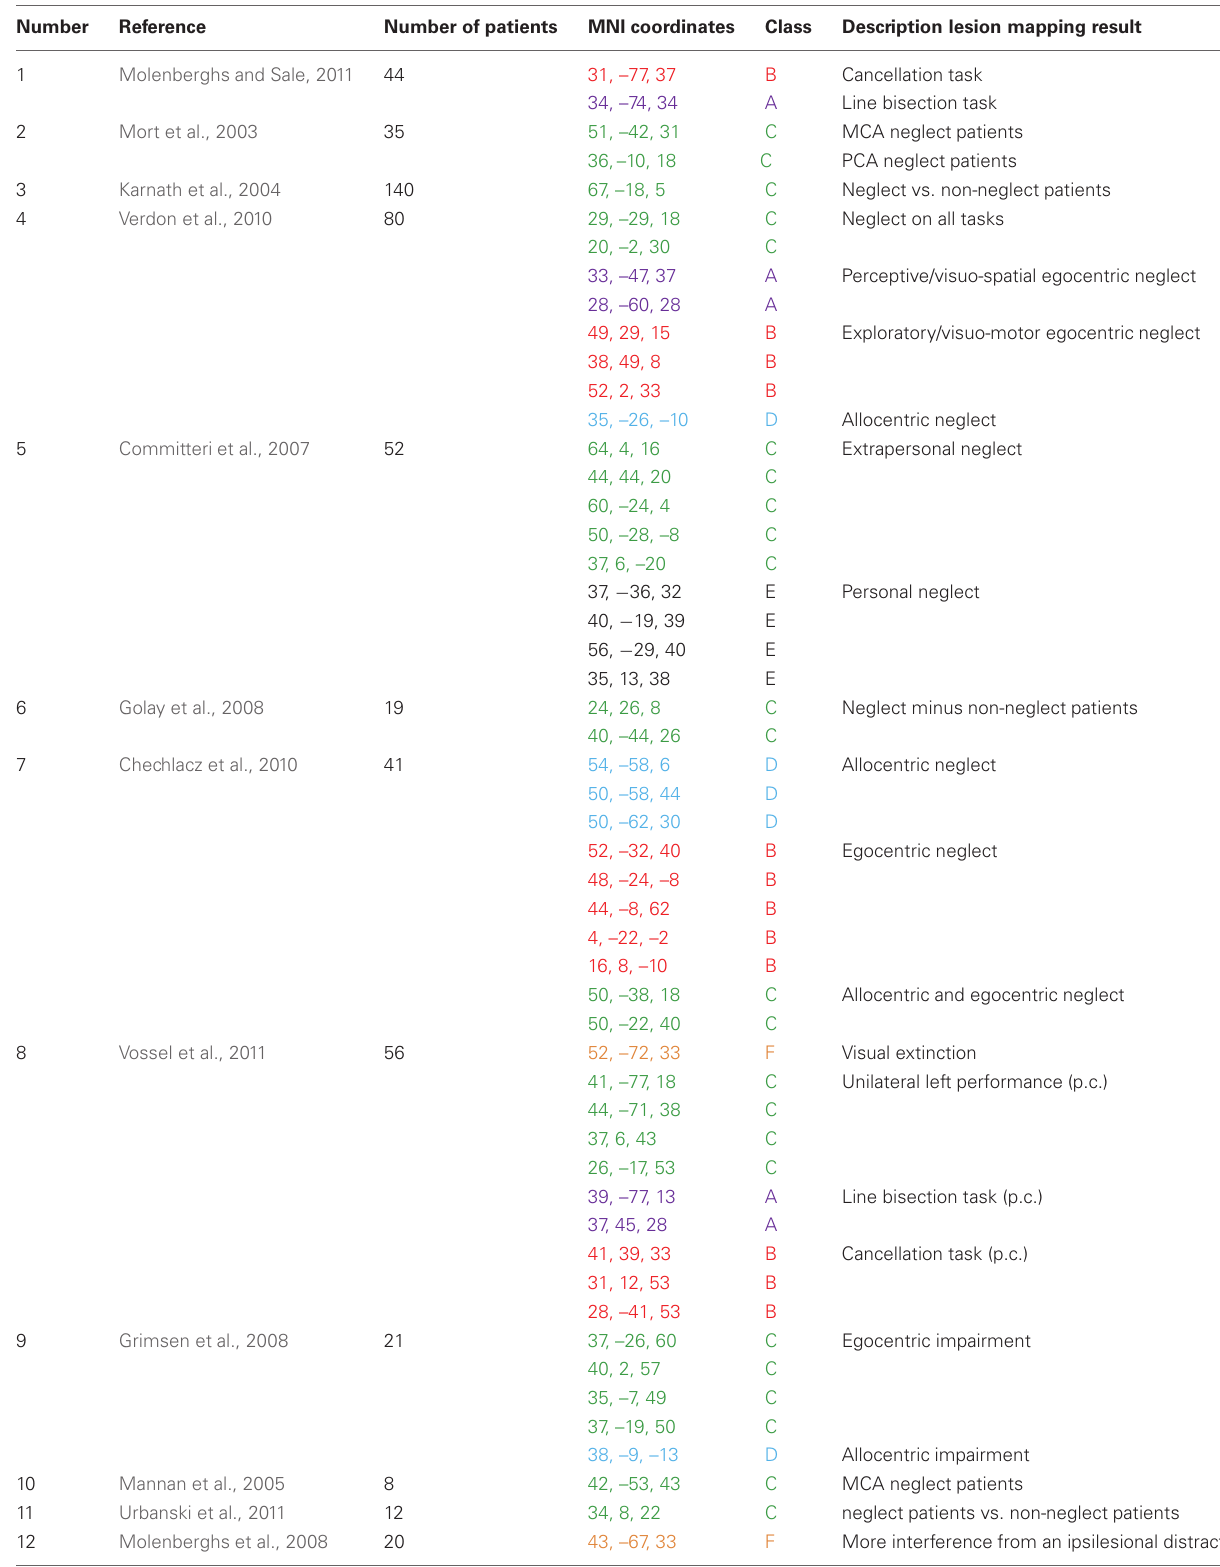
Table 1 | Overview of the 20studies and peak coordinates used in the ALE